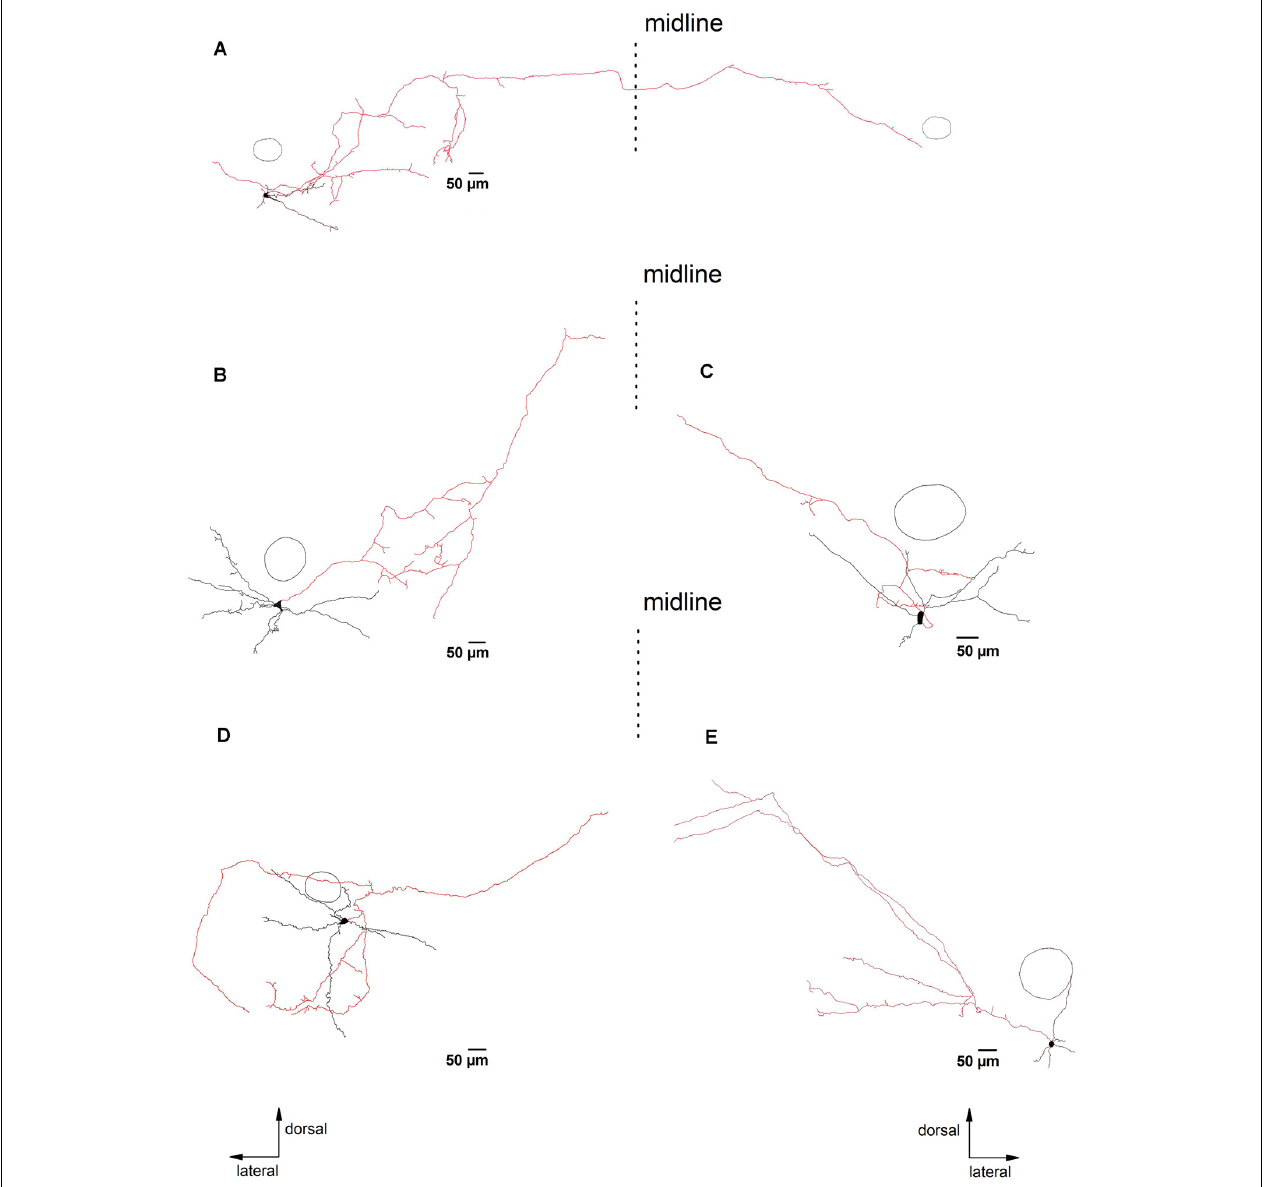
FIGURE 4 | PreBötC glycinergic neurons with long axonal projections. Panels (A–E) illustrate biocytin-filled putative glycinergic neurons with axons that project more than 500 µ m away from the soma. The dashed lines indicate the midline of the slice. Neurons in (A,B,D) were located on the left side, while neurons in (C,D) were from the right side of the slice. The reconstructed axons are depicted in red. The circle indicates the location of NA as an orientation reference. Note that the neuron in (A) projects to the contralateral preBötC. The other four neurons project in the direction of the hypoglossal nucleus (n.